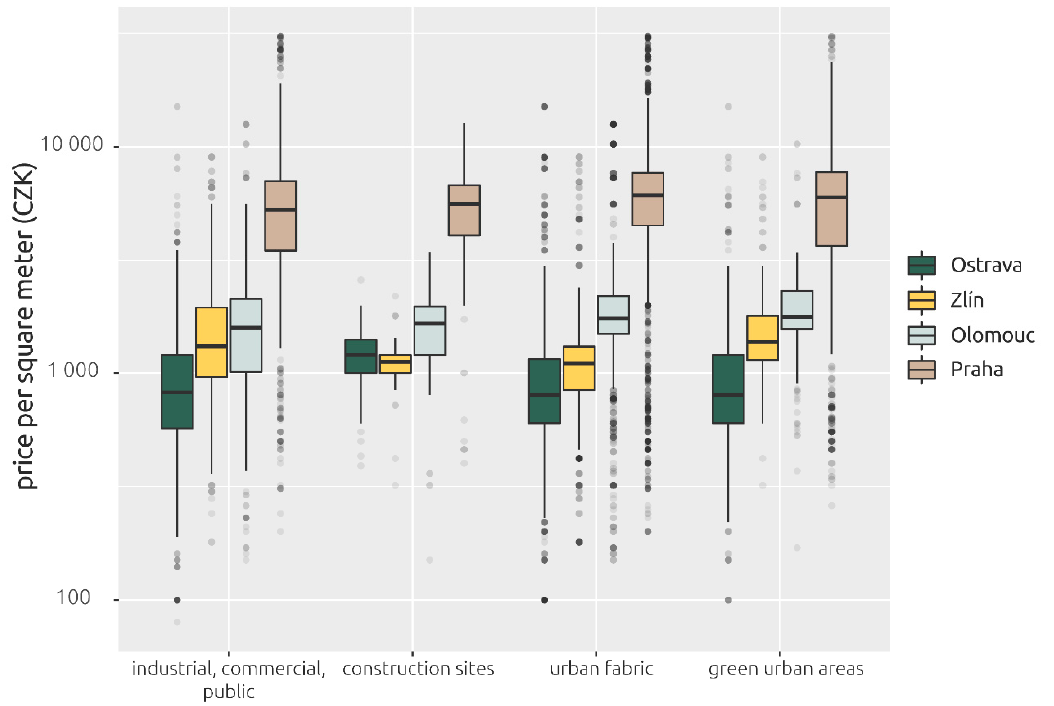
Figure 8. Land price related to selected land use types.